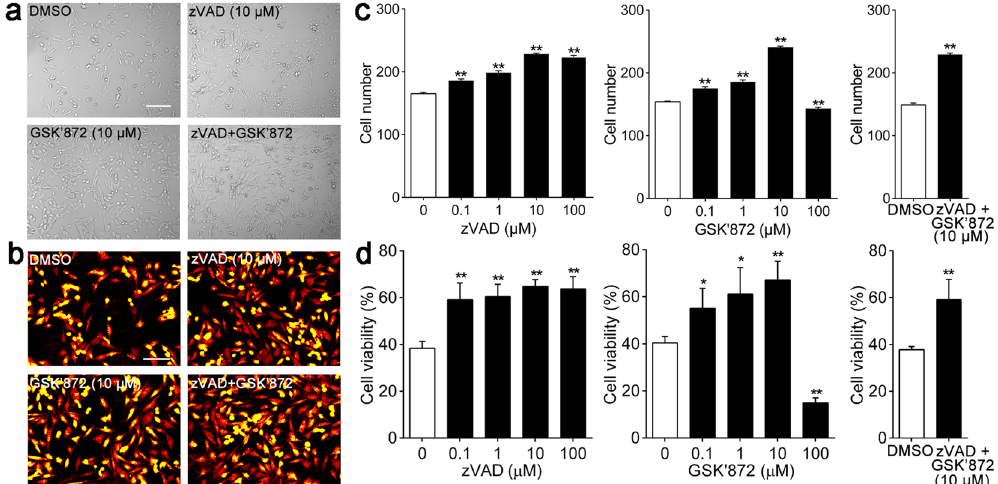
Figure 2. zVAD, GSK’872 and combinative intervention alleviated morphologic alterations and attenuated cell death induced by OGD and reoxygenation in HT-22 cells. ( a and b ) Representative images of HT-22 cells morphologic changes during reoxygenation were captured by light microscope and digital hologram microscope. Scale bars = 100 μ m. ( c ) Cell viability was determined by MTS assay after 9 h of reoxygenation. ( d ) Alterations of HT-22 cell number during reoxygenation were quantified and analyzed by HoloStudio 2.6 software. * p < 0.05, ** p < 0.01 vs . control group. Also see Supplementary Figure S3 and Video